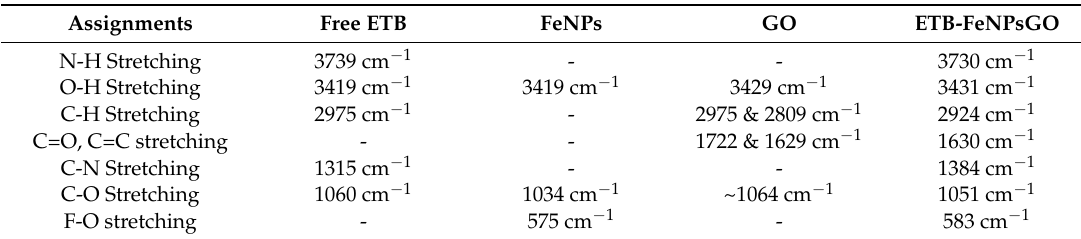
Table 1. FTIR assignments of absorption bands of free ETB, GO, FeNPs, and multifunctional nanoformulation